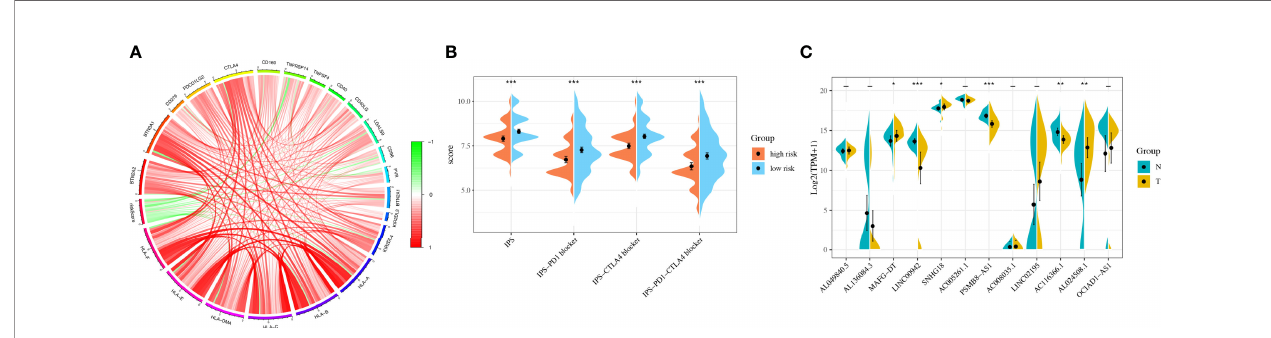
FIGURE 6 | Immunotherapy analysis and validation in the original cohort. (A) The correlation between immune checkpoint genes and riskscore. (B) The IPS, IPS- PD1 blocker, IPS – CTLA4 blocker, and IPS – PD1 – CTLA4 blocker values in the high- and low-risk groups. (C) The RNA sequencing (RNA-Seq) results of 12 lncRNAs in bladder cancer tissues and normal tissues. *P < 0.05, **P < 0.01, ***P < 0.001.